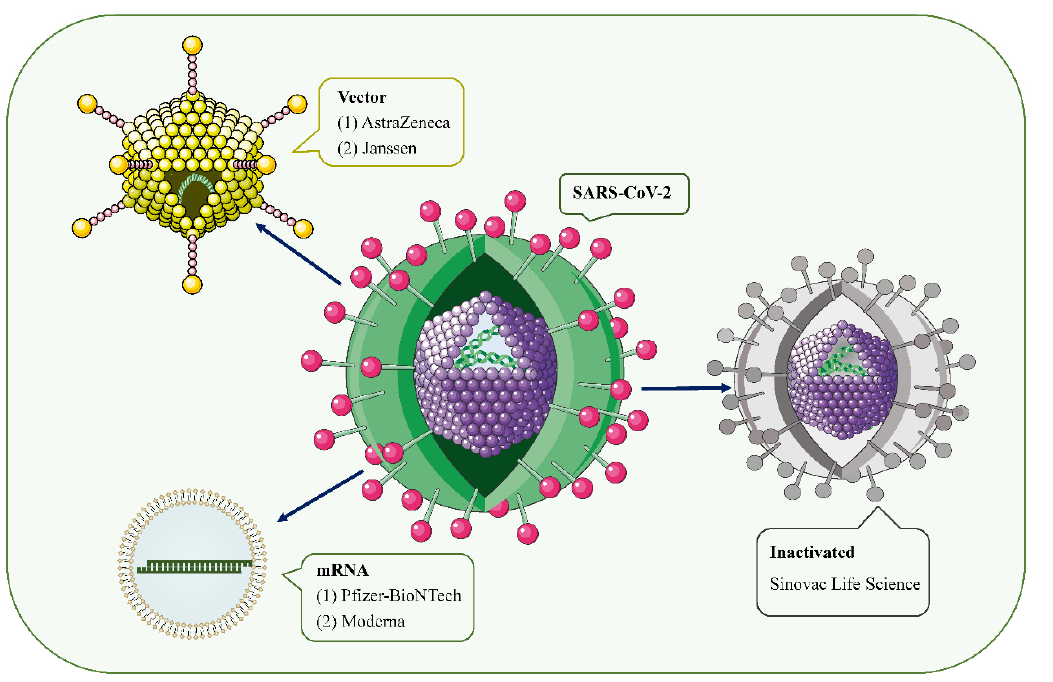
Figure 1. SARS-CoV-2 and the main types of vaccines that may trigger AKD. SARS-CoV-2 is a positive-sense single-stranded RNA virus with a lipid bilayer consisting of the spike S protein and membrane and envelope proteins. mRNA vaccines deliver transgenic mRNA through lipid nanoparticles as carriers. Viral vector vaccines utilize adenovirus and integrate genetic material from SARS-CoV-2 into its genome. Inactivated vaccines involve SARS-CoV-2 that has been killed by physical or chemical means.